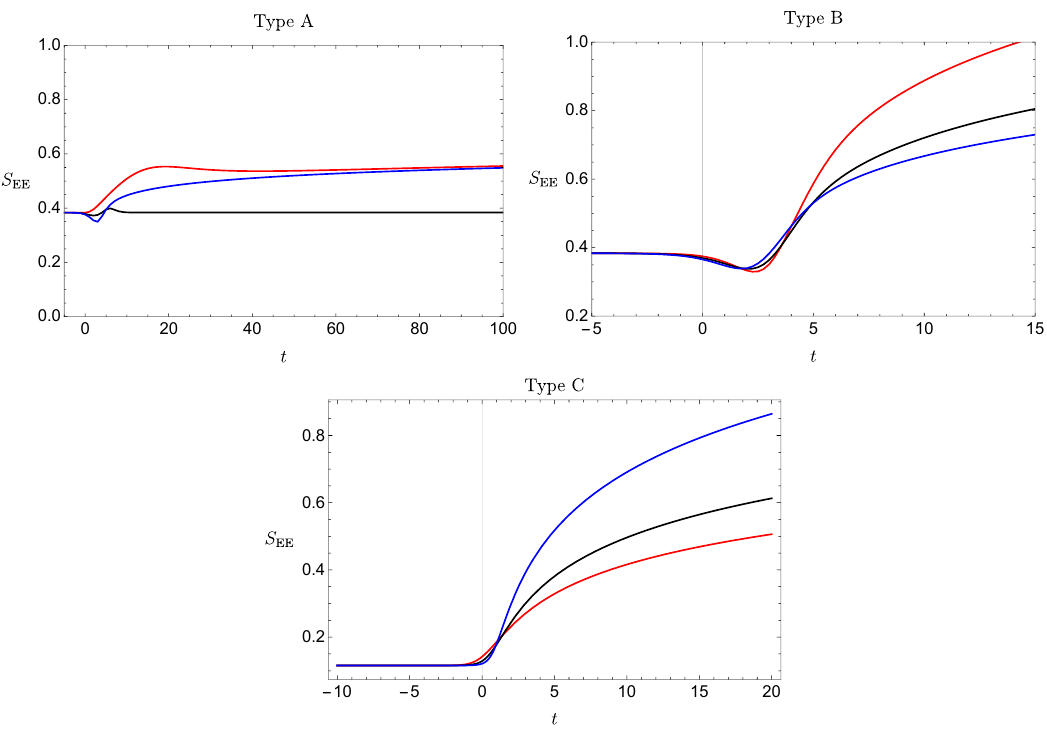
Figure 12 . Entanglement entropy for a co-moving, semi-infinite interval with fixed endpoint x a = Z ( t ) + ∆ x , where ∆ x = 5 for all three plots. The red, black, and blue curves correspond to subclasses + , 0 , − with n = 2 , 1 , and 1 , respectively. The mapping functions p ( u ) are chosen as in 2 figure